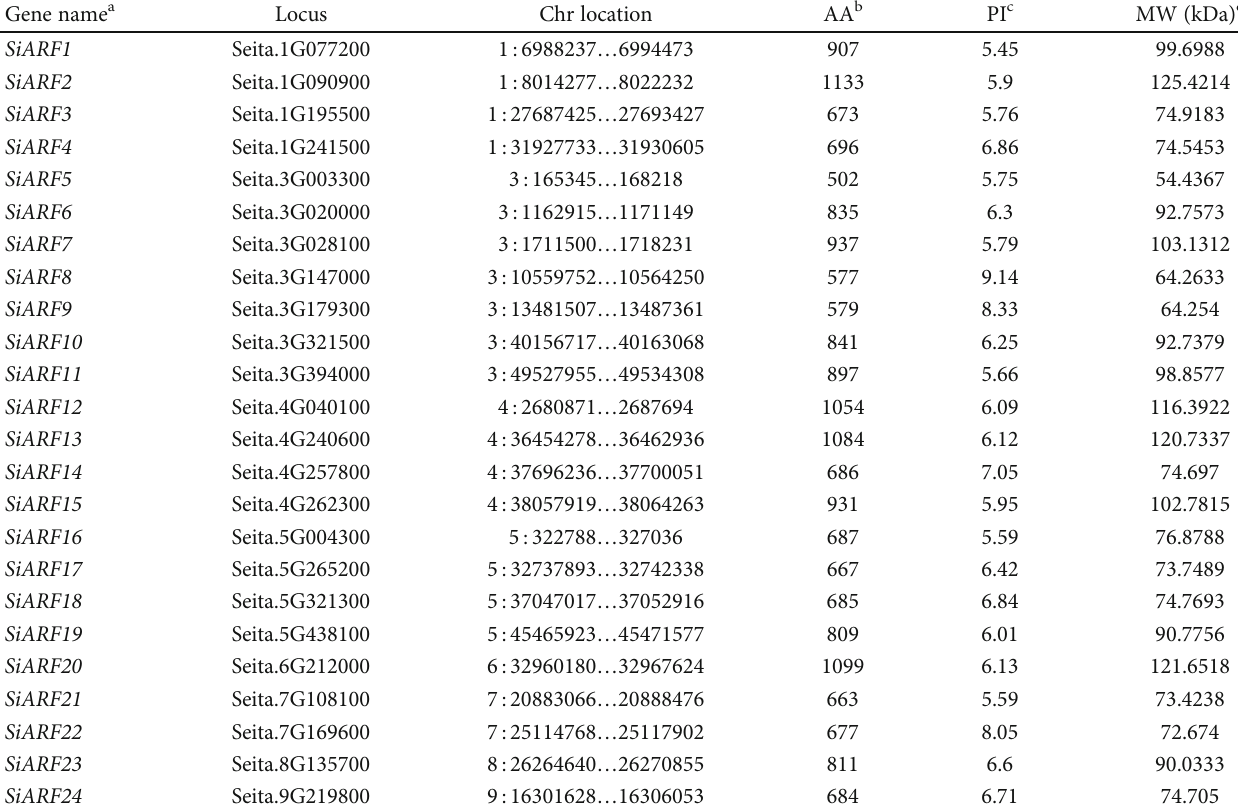
Table 1: The characteristics of identi fi ed auxin response factor gene family in Setaria italica .